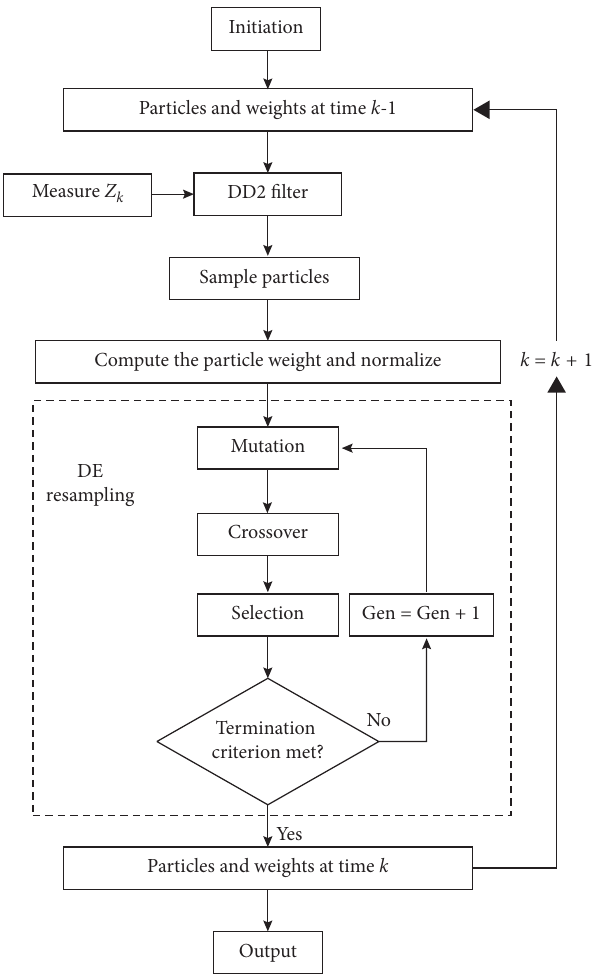
Figure 1: The basic steps of the proposed